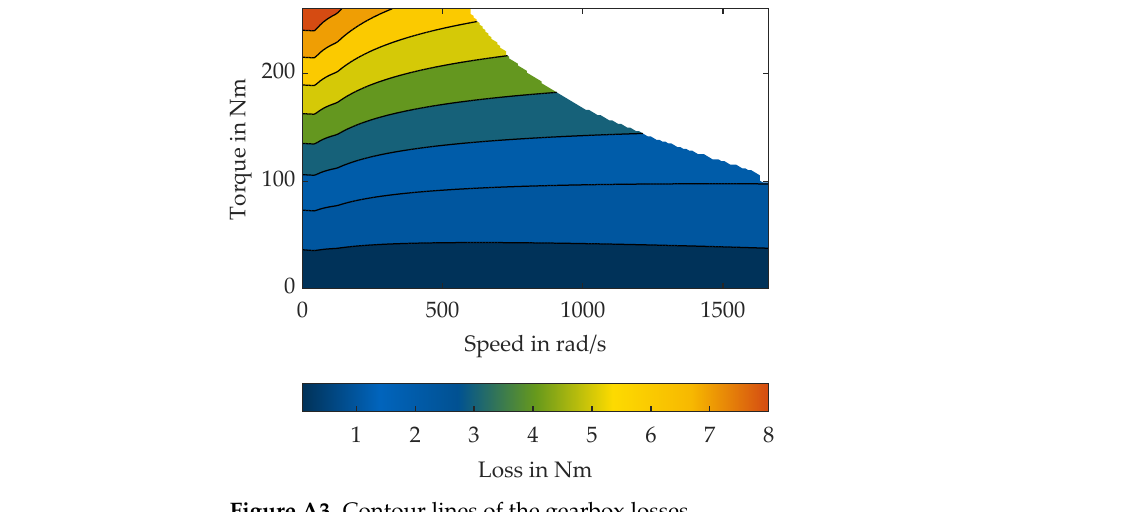
Figure A3. Contour lines of the gearbox losses.